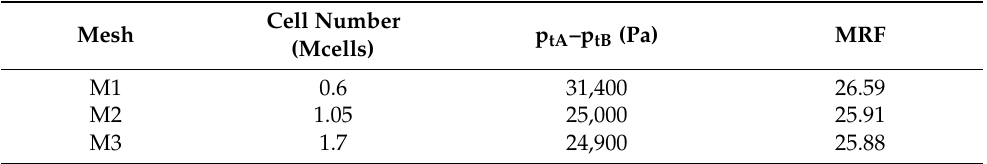
Figure 4. Mesh of the volute with the prism layer detail on the volute inlet. Table 2. Mesh configurations used for the mesh sensitivity with the total pressure difference and the mass flow rate through the cavity.